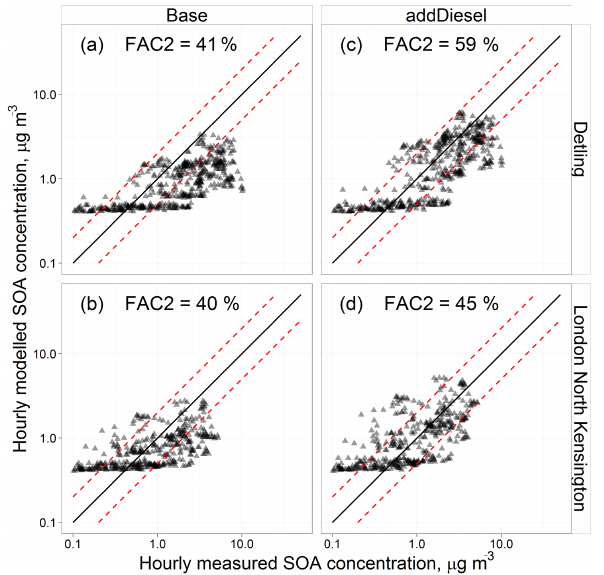
Figure 14. Scatter plots of measured and modelled hourly SOA concentrations during the winter 2012 IOP: (a) Base simulation at the Detling rural background site; (b) Base simulation at the North Kensington urban background site; (c) addDiesel simulation at the Detling rural background site; (d) addDiesel simulation at the North Kensington urban background site. The straight lines are the 2:1, 1:1, and 1:2 lines.